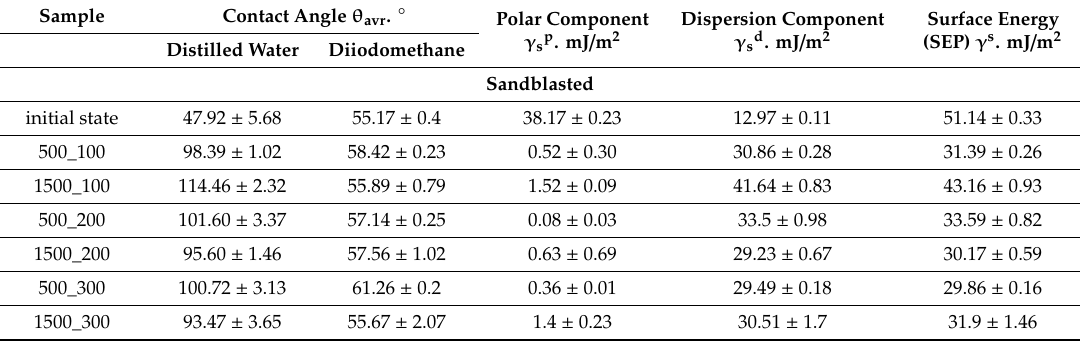
Table 4. Wettability and surface free energy results for the surface-modified 316LVM steel. Sample Contact Angle θ avr .